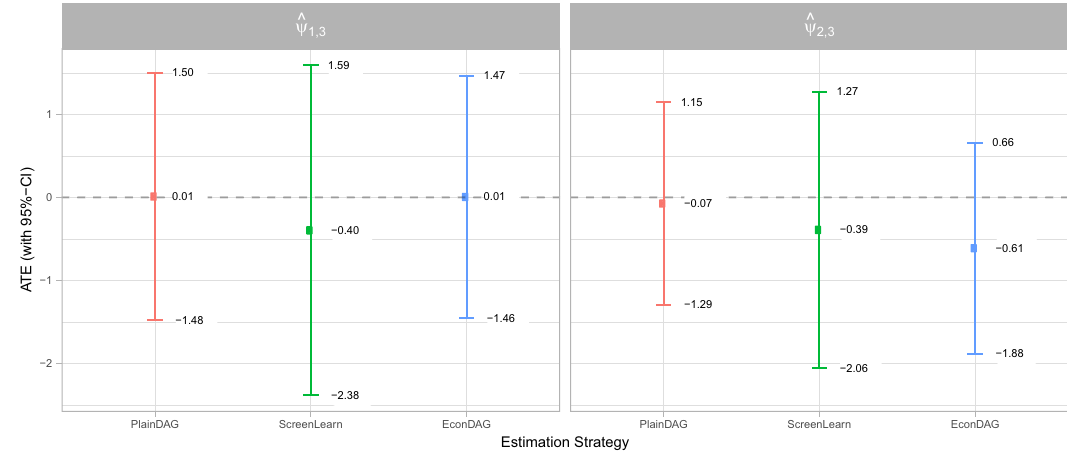
and ψ ˆ for the three di ff erent estimation Figure 2: ψ ˆ 1,3 2,3